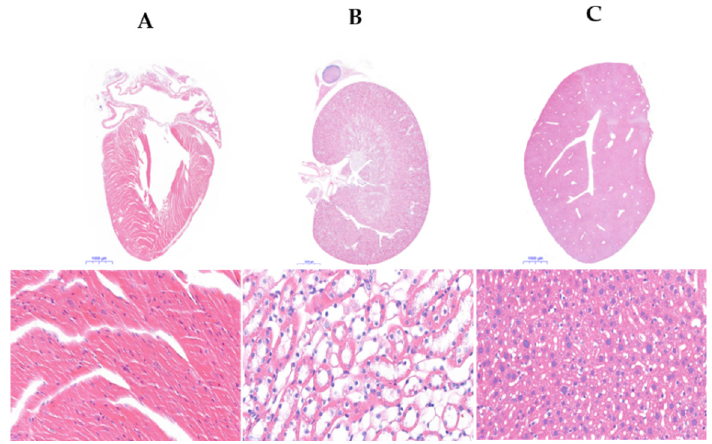
Figure 10. Histological specimens of heart ( A ), kidney ( B ), and liver ( C ) samples of mice injected with Gd-DO3A-Am-PBA. Mice were sacrificed immediately after 24-h MR imaging. All organs presented a normal appearance in macroscopic and microscopic observations. The scale bar is 25 μ m.